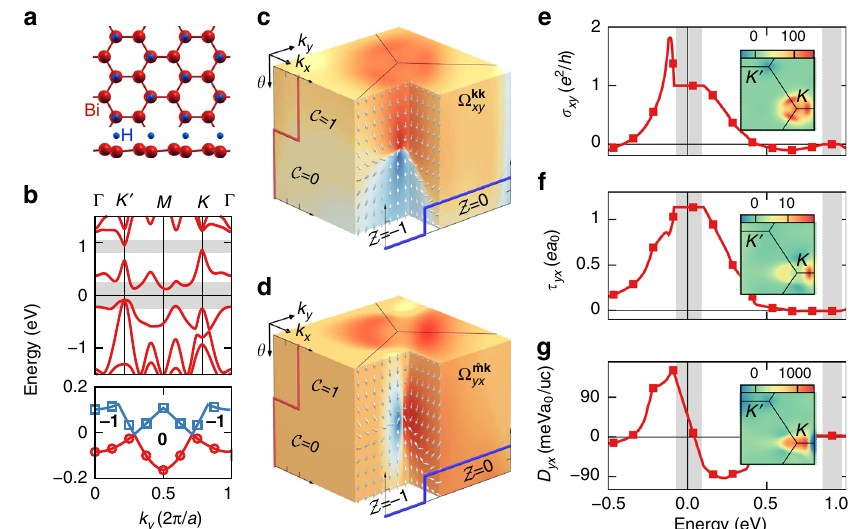
Fig. 3 Magnetoelectric properties of a mixed Weyl semimetal. a Crystal structure of the semi-hydrogenated Bi(111) bilayer. b First-principles band structure for an out-of-plane magnetization, where the region of the topologically complex band gap and the trivial one above are highlighted. In addition, the evolution of valence band maximum (red circles) and conduction band minimum (blue squares) with k y is shown. Bold integers denote the mixed Chern number Z , and a is the in-plane lattice constant. c , d Monopole-like fi eld of momentum space and mixed Berry curvatures near one of the mixed Weyl points. Arrows indicate the direction of the curvature fi eld ð(cid:3) Ω ^ mk yy ; Ω ^ mk yx ; Ω kk xy Þ , and a logarithmic color scale is used to display two of its components, where dark red (dark blue) denotes large positive (negative) values. e , g Energy dependence of σ xy , τ yx , and D yx for magnetization perpendicular to the fi lm plane. Insets show the microscopic distributions in momentum space near K and K